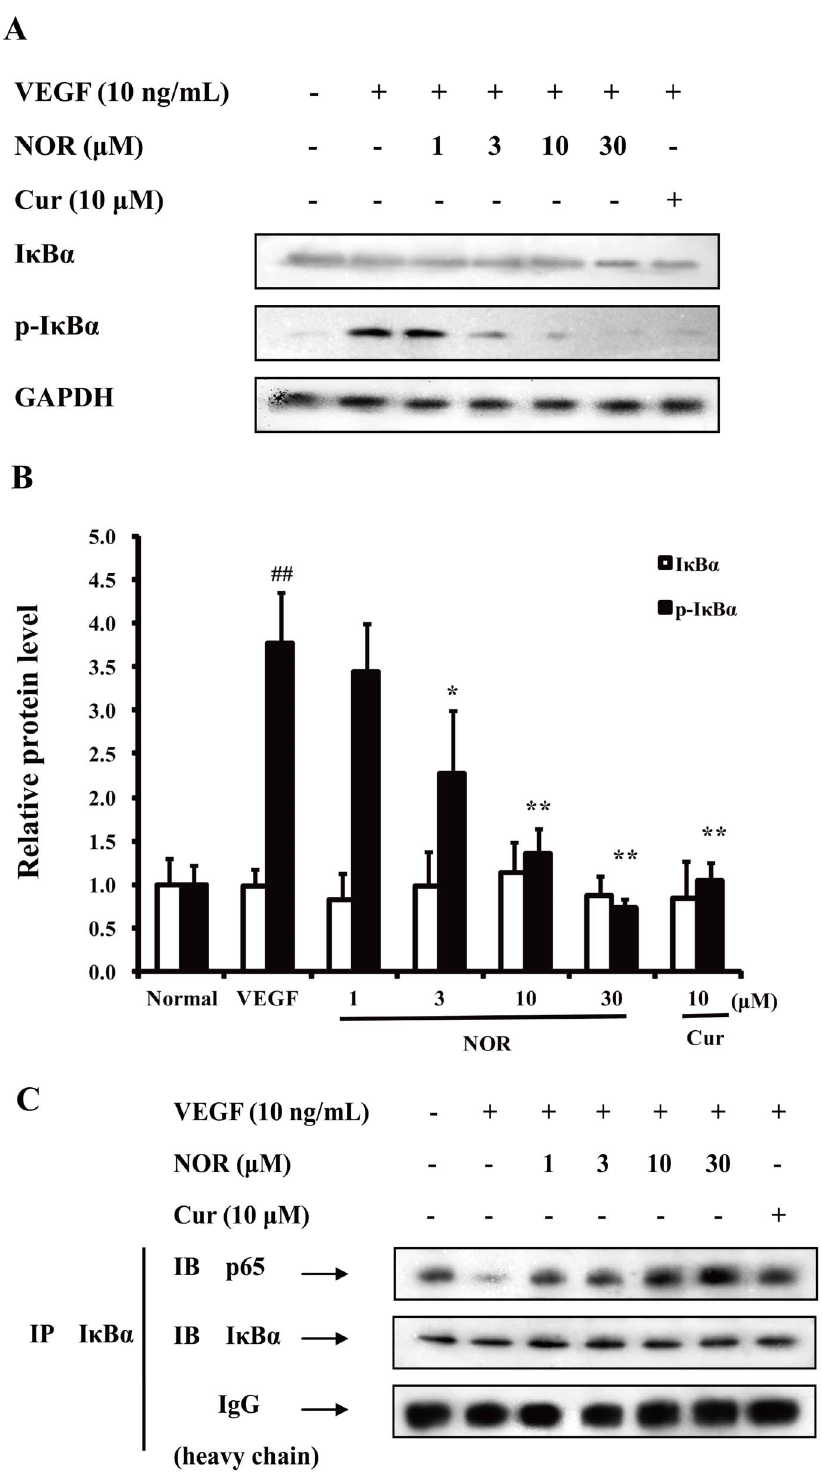
Figure 7. The effect of NOR on the VEGF-induced activation of the NF- k B pathway. ( A ). Effect of NOR on VEGF-induced expressions of I k B a and p-I k B a in HUVECs. ( B ). Quantification of I k B a and p-I k B a expressions. ( C ). Effect of NOR on the disruption of p65/I k B complex in VEGF-activated HUVECs. Cells were treated with NOR or Cur in the presence of VEGF for 24 h. Then cell lysates were immunoprecipitated with I k B a antibody and immunoblotted with p65 antibody. The data were expressed as mean 6 SD of three independent experiments. ## P , 0.01 vs . normal group; * P , 0.05, ** P , 0.01 vs. VEGF group. NOR, norisoboldine; Cur, curcumin.